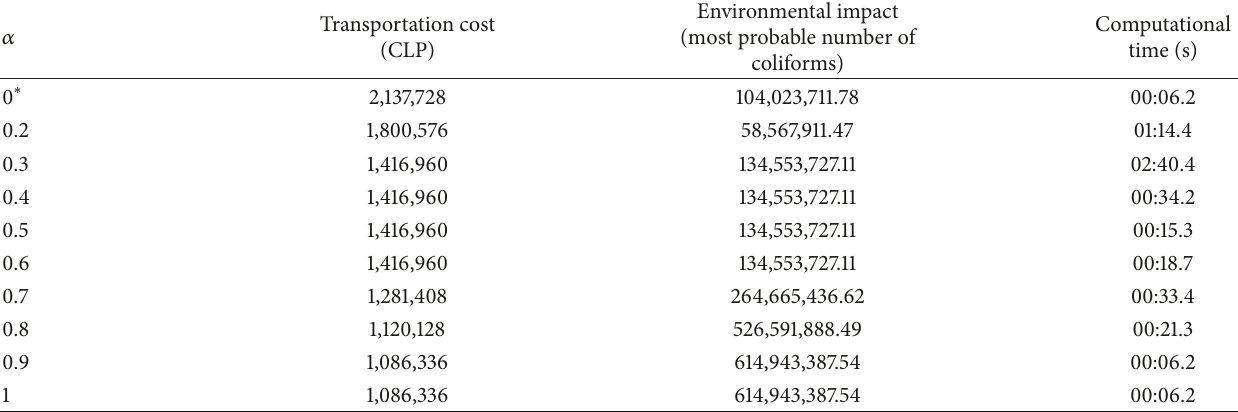
Table 3: Results for total transportation cost and environmental impact using the weighted sum technique.